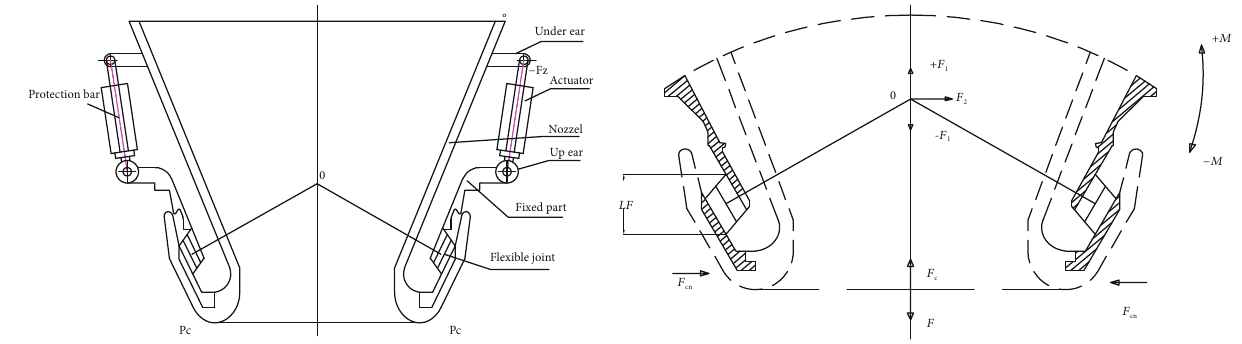
Figure 1: The mounting position and force form of the fl exible joint in the